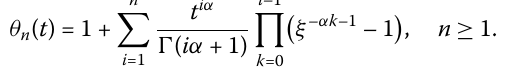
with the n -term approximate solution θ n ( t ) defined